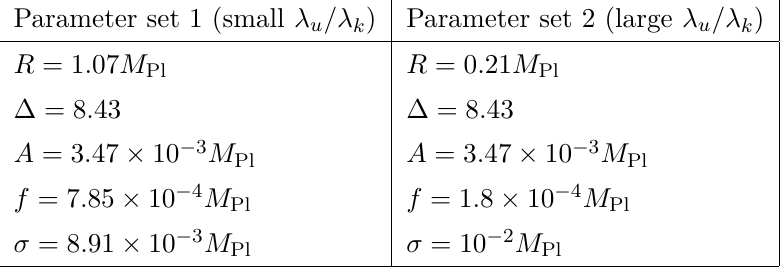
Table 1 . Values of the helix potential parameters (cf. (4.10)) showcased